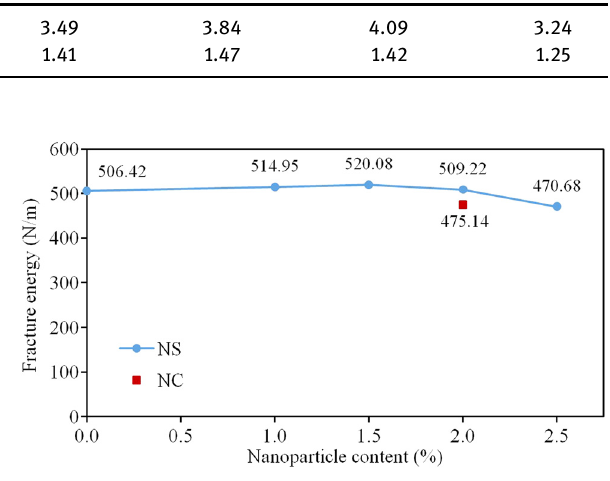
Table 6: Tensile properties of mixtures with di ff erent NS content Mix